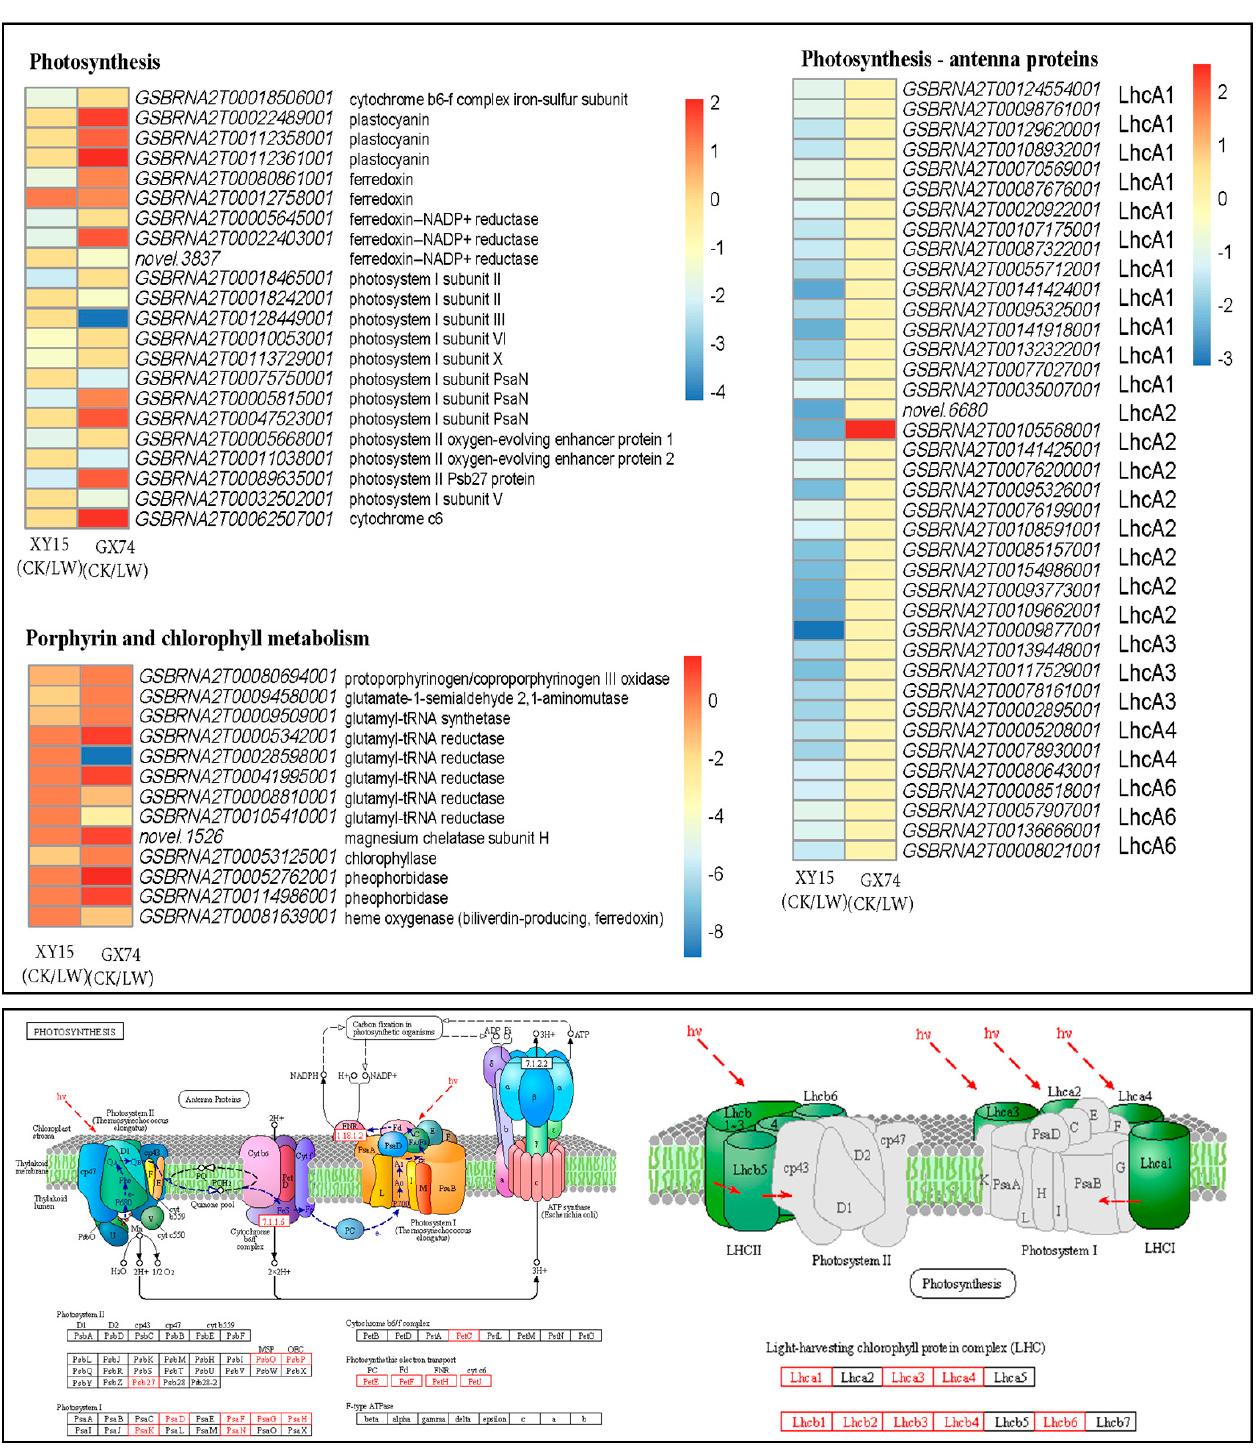
Figure 5. Differential regulation of photosynthesis, photosynthesis—antenna proteins, and chlorophyll-biosynthesis-related genes in XY15 (cold-sensitive) and GX74 (cold-tolerant) rapeseed siliques in response to cold treatment. The heatmaps represent the log2 foldchange values. The lower two panels showing photosynthesis as well as antenna pathways were generated using KEGG pathway database [25]. The differentially expressed genes are highlighted as red text. CK and LW represent control and cold treatments. The gene name abbreviations refer to the full names presented in Table S5.